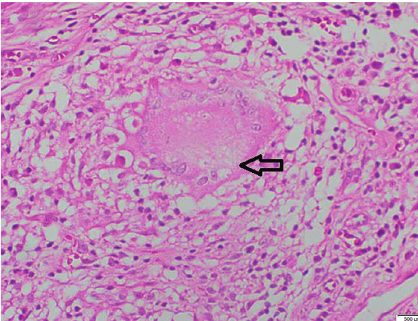
Figure 4: Midpower view ( × 100) of the serosa and the meso- appendix shows numerous granulomata composed of epithelioid cells, Langerhans giant cells, and lymphocytes with central spotty caseous necrosis. H&E stain. The black arrow points at caseating